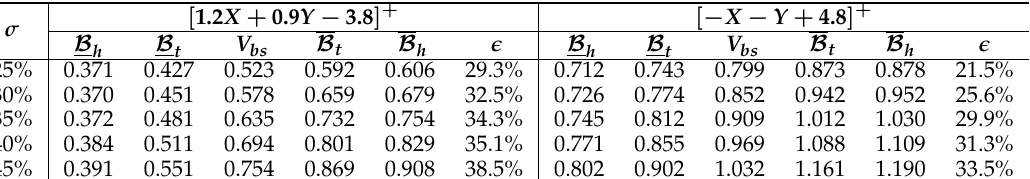
Table 4. Sensitivity of Valuation Bounds Against Volatility. The time-zero prices of the exchange rates X and Y are 1.6 and 2.5. It is assumed that the underlying processes X and Y are correlated with ρ = 0.20 with the identical annualized volatility, e.g., σ X = σ Y = σ . Both the domestic and foreign interest rate are zero. All prices are attained within a price mesh of u = 1.12 and J = 30. Two basket options mature at T = 1 (year). σ